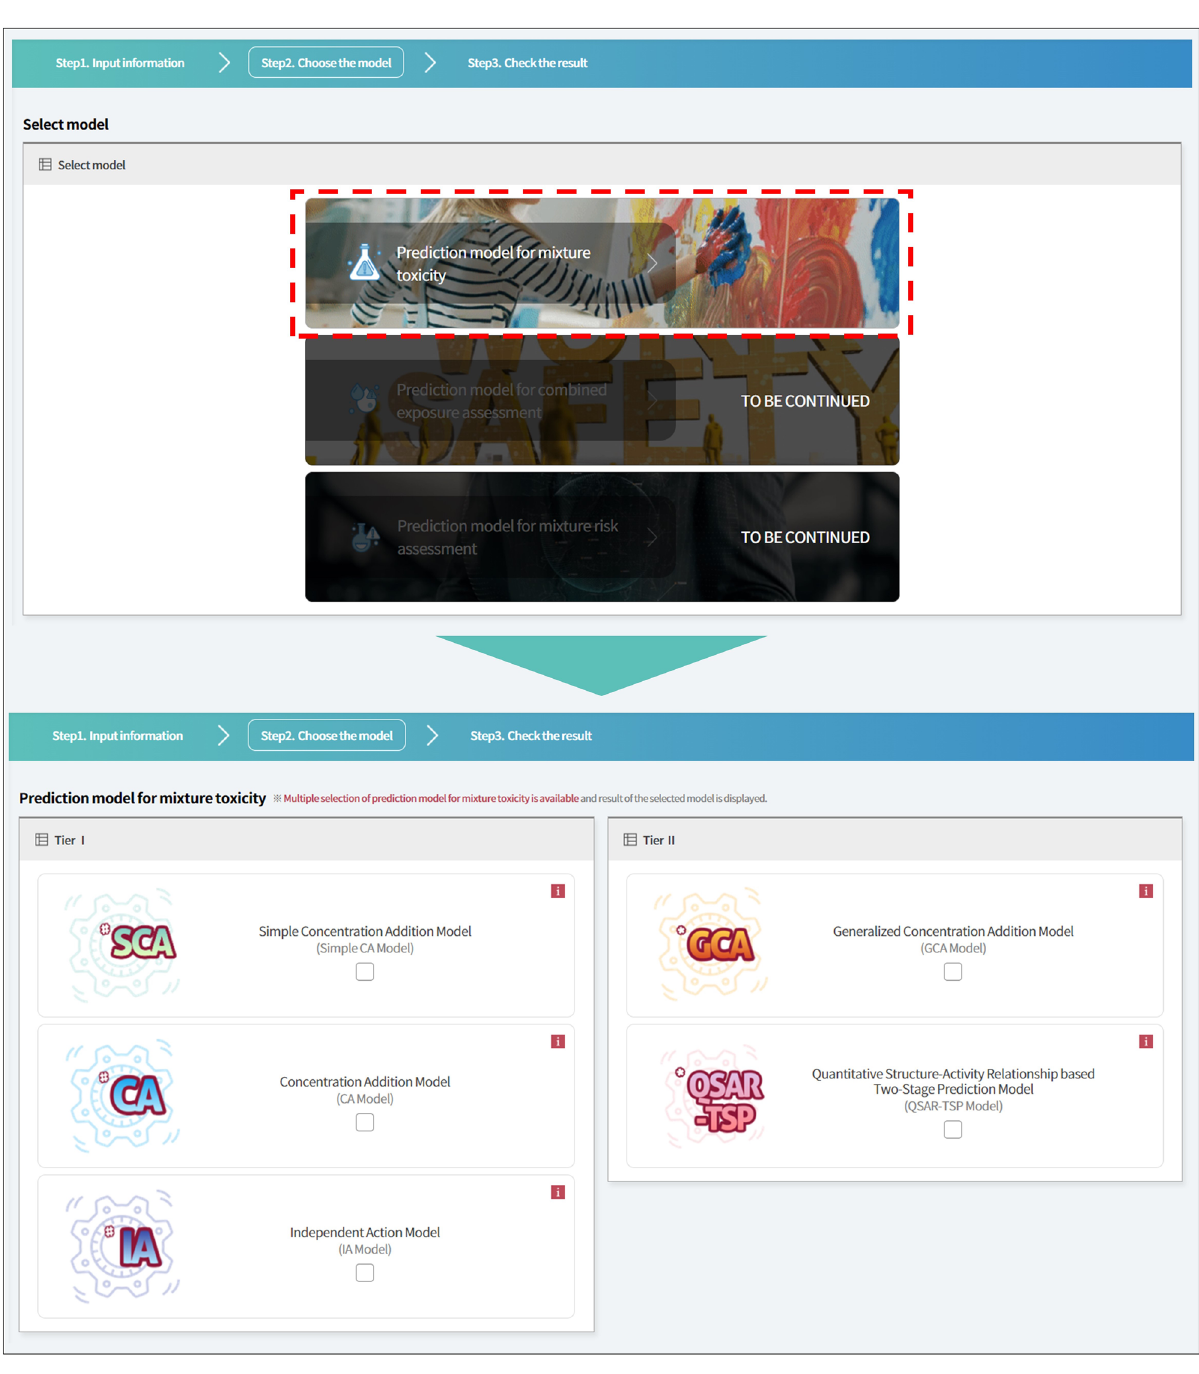
Figure 4. MRA Toolbox graphical user interface (GUI) to select mixture toxicity predictive